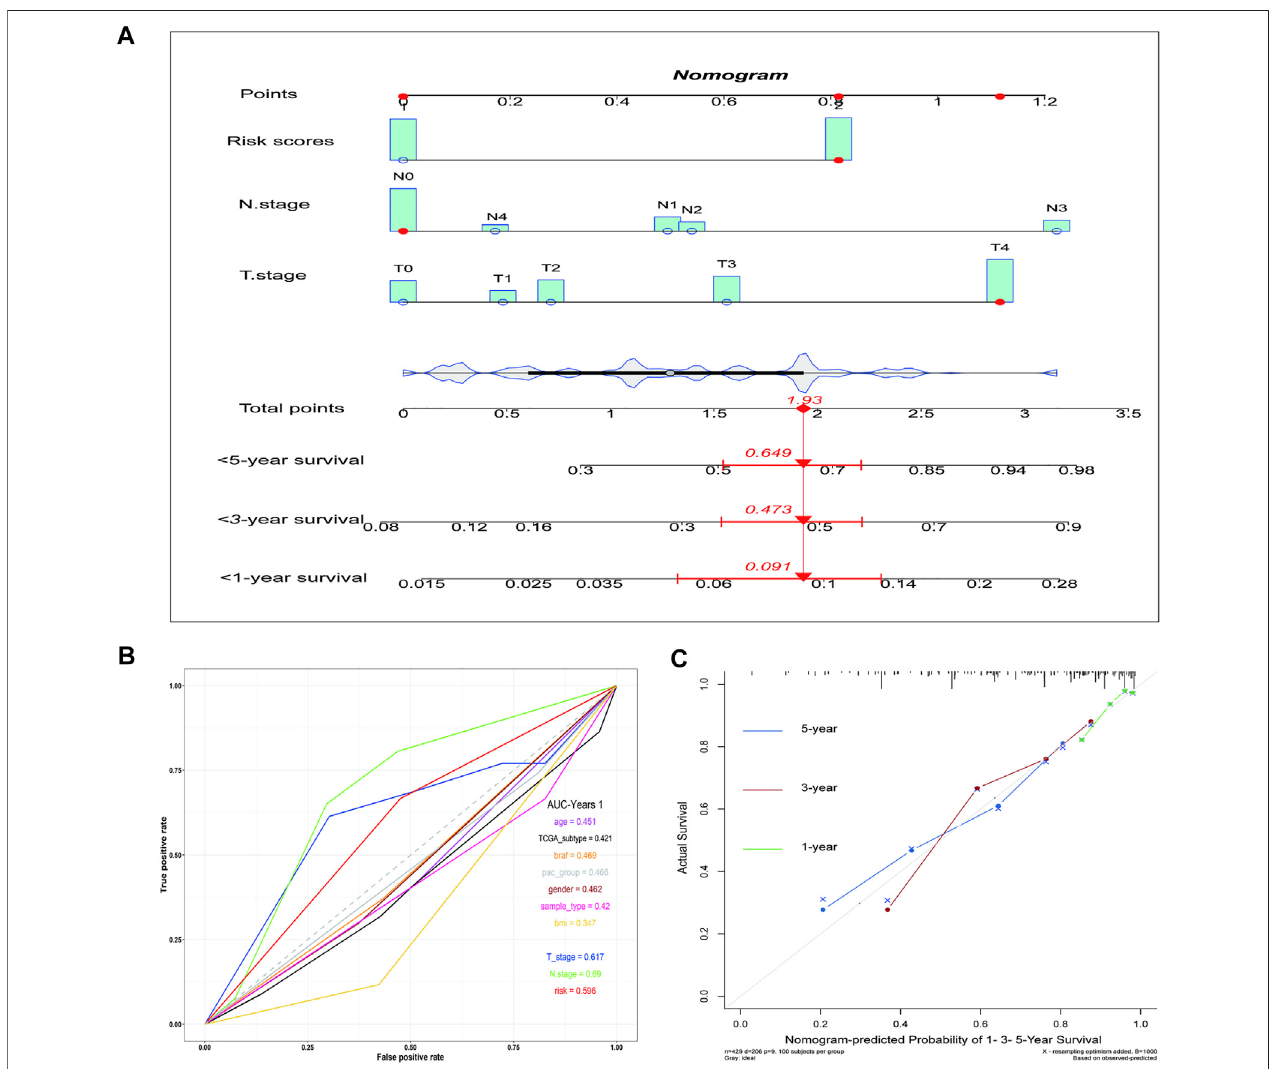
FIGURE 4 | The nomogram shows the impact of various clinical features on survival prognosis in melanoma. (A) A nomogram of the melanoma cohort used to indicate the clinical information and overall survival. (B) ROC curve of clinical features. (C) Calibration maps used to predict the 1, 3, and 5-years survival. The x -axis and y -axis represent the expected and actual survival rates of the nomogram. The solid line represents the predicted nomogram, and the vertical line represents the 95% con fi dence interval.